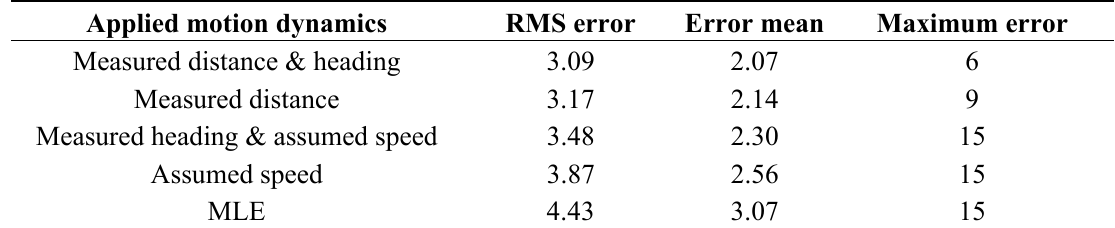
Table 5. The positioning error statistics of the grid-based filter algorithm using different combinations of MDI (unit: